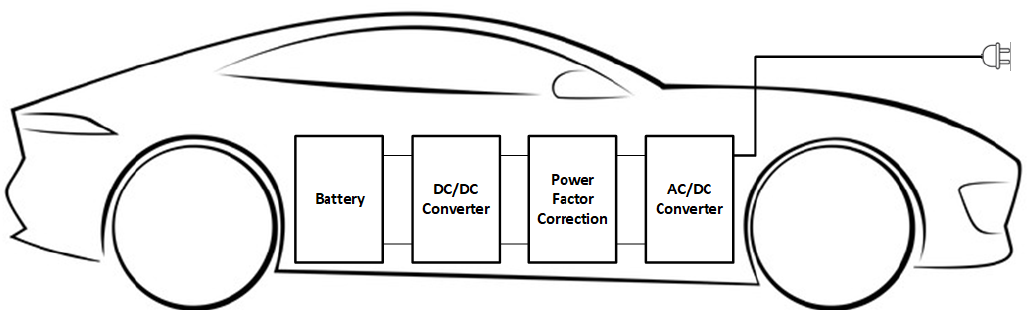
Figure 3. Onboard EV charger components.